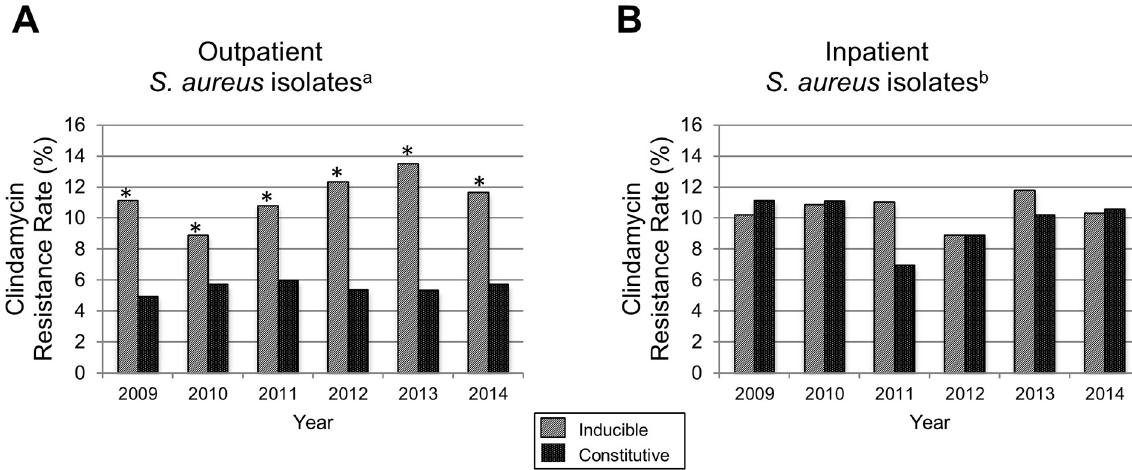
Fig 3. Inducible and constitutive clindamycin resistance by year (2009–2014) in outpatient (A) and inpatient (B) S . aureus isolates from NCH. NCH indicates Nationwide Children’s Hospital. a Number of outpatient S . aureus isolates (n = 20,450). b Number of inpatient S . aureus isolates (n = 5,317). � p < 0.05, determined using the χ 2 test for